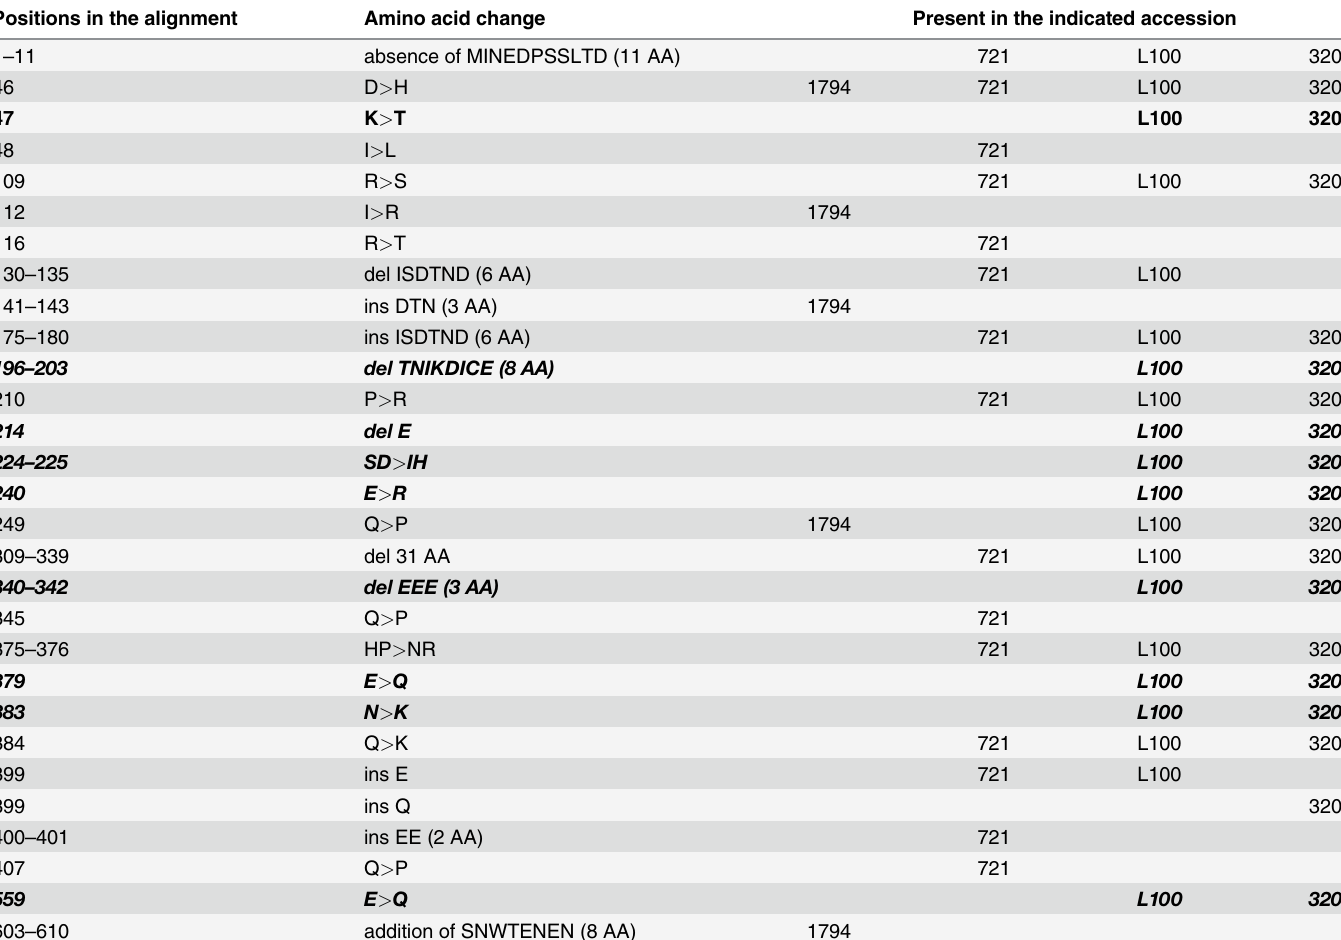
Table 1. Variable positions in the alignment of the polypeptidees derived from the accD alleles, amino acid changes as compared to WL1238 and their occurrence in the pea accessions studied. Positions in the